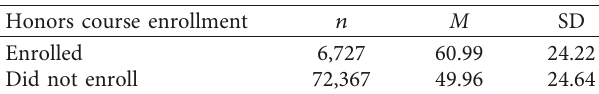
Table 3: Descriptive statistics for academic challenge benchmark scores by honors course enrollment status.